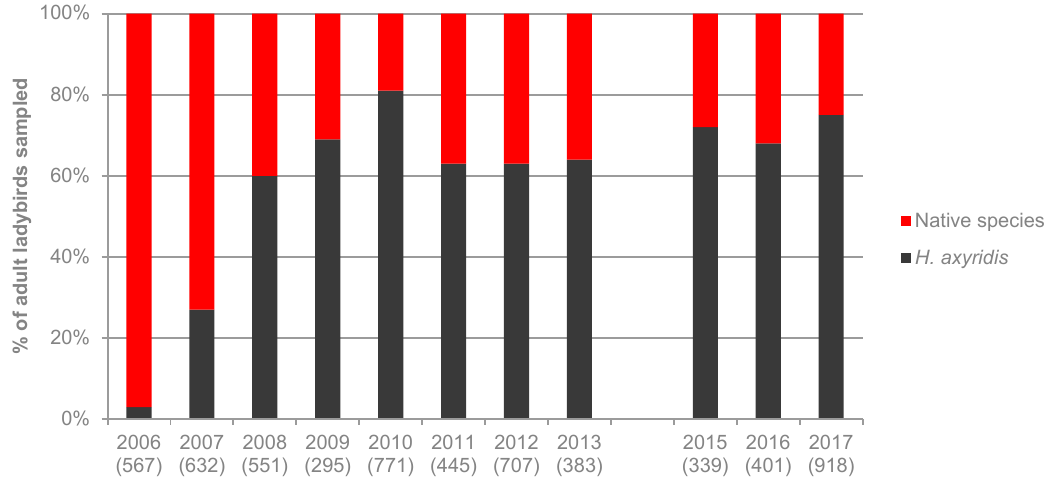
Figure 1. Percentage of Harmonia axyridis and native species at the 15 broadleaved hedges from 2006 to 2017. Numbers between parentheses indicate the number of adult ladybirds collected. Table 1. Species and number of adult ladybirds collected at the 15 broadleaved hedges from 2006 to 2017. Numbers between parentheses indicate the number of collections. Ladybirds were not sampled in 2014.